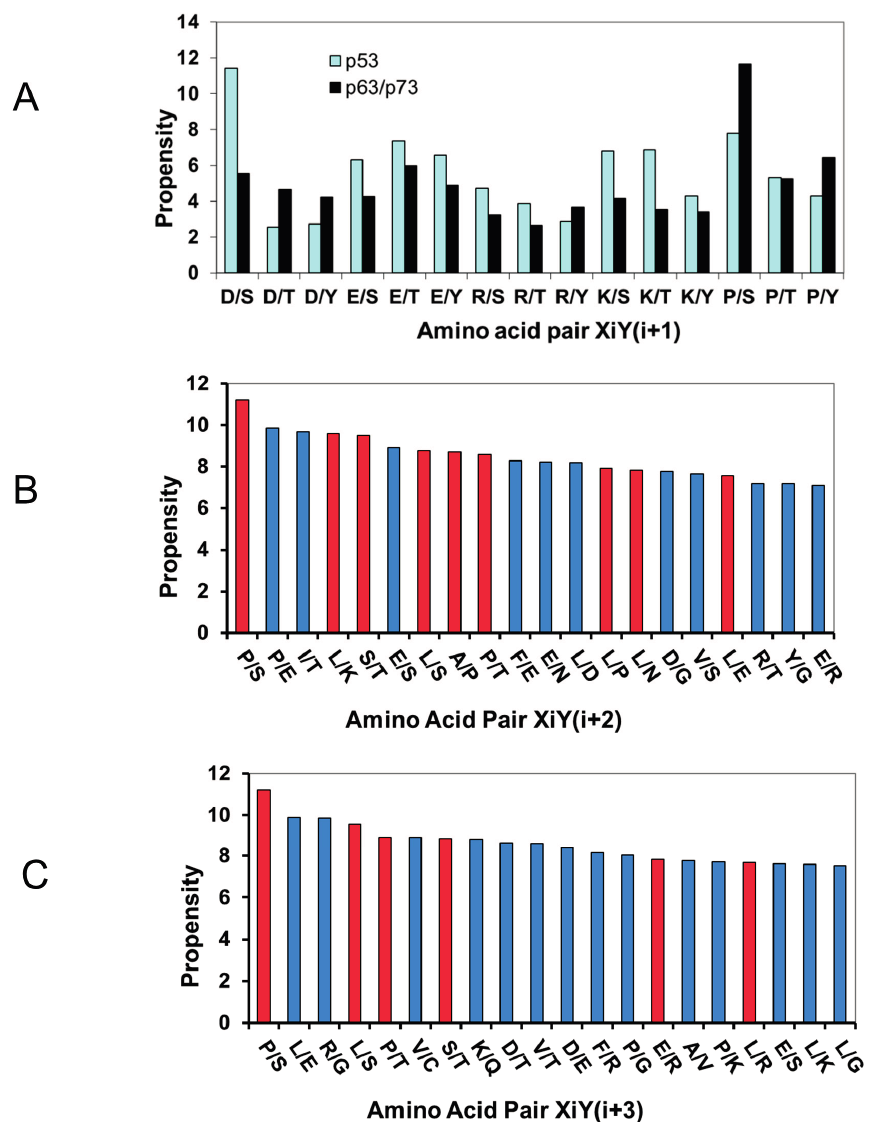
Figure 1. Amino acid pair propensities in p53 phosphorylation motifs follow similar trends as those of other p53 protein families, indicating evolutionary optimization of p53 phosphorylation motifs for function. ( A ) Comparison of the propensity of a charged residue (and proline) adjacent to potential phosphorylation sites shows that p53 prefers acidic residues near Ser/Thr, while p63/p73 prefers proline near Ser/Tyr. The distributions of the amino acid pair propensities DPxy among p53 pairs at the position ( B ) X (tripeptide X × Y motif); and ( C ) pairs at the position X The red bar indicates pairs that are preferred for all p53, p63, and p73